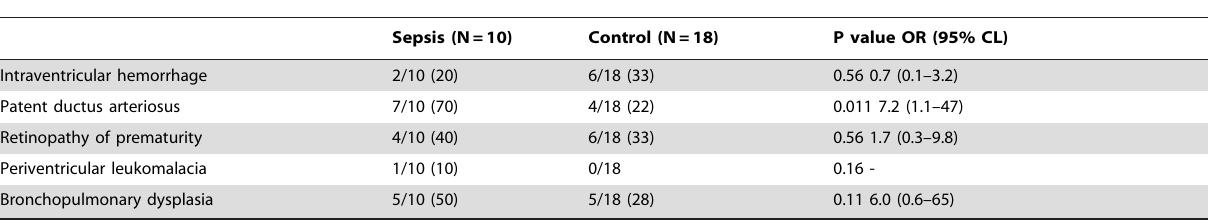
Table 2. Major Outcomes.– no./total no. (%).